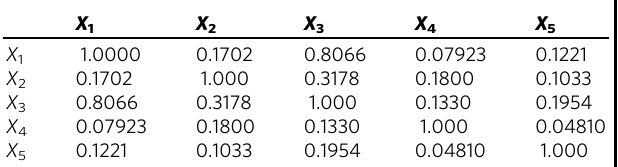
Table 7 Matrix of correlations between the independent variables. Source: Own